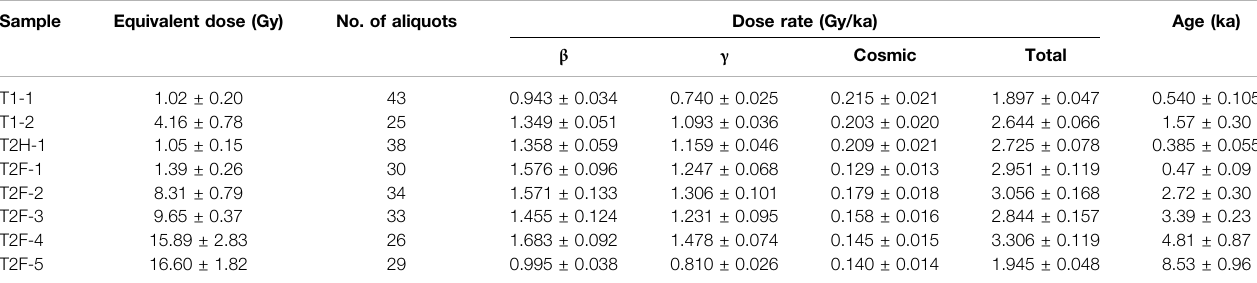
TABLE 2 | Conventional OSL dating from the Dungsam Chu site. Results of OSL analysis on samples. The input variables for individual samples used for dose rate and age calculations are listed in Supplementary Table S1 .